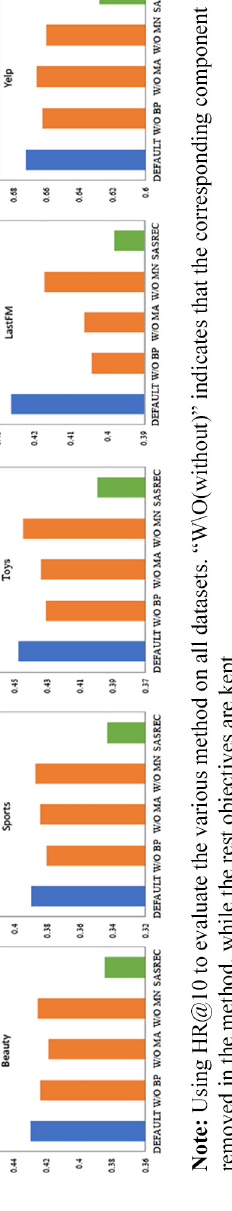
Figure 2. Ablation study of our